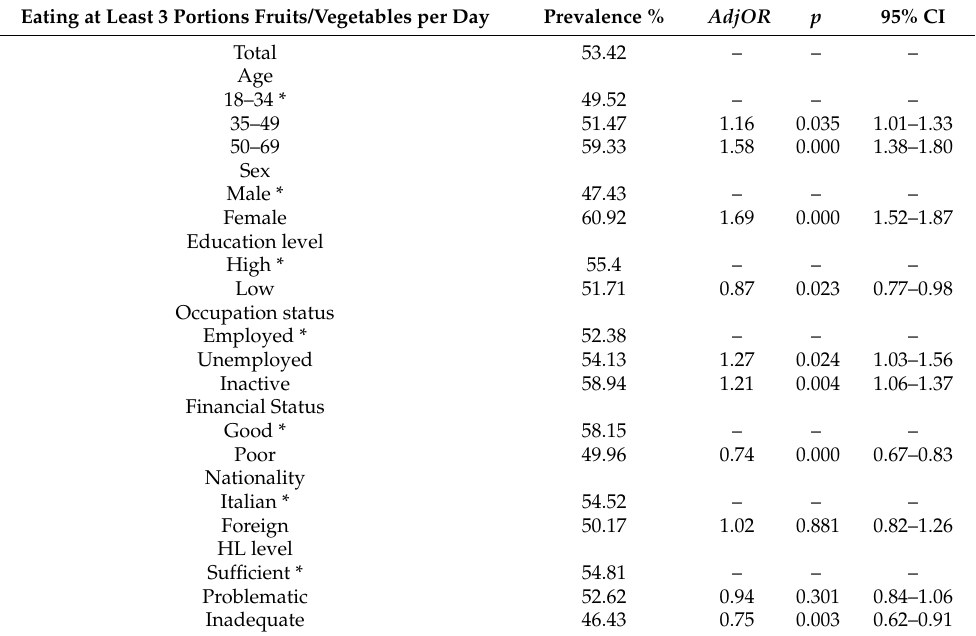
Table 3. Multivariate logistic regression analysis: predictors of eating at least 3 portions of fruits/vegetables per day (the logistic regression model includes all the covariates in the table); AdjOR: Adjusted Odds Ratio; CI: Confidence Interval; HL: Health Literacy.